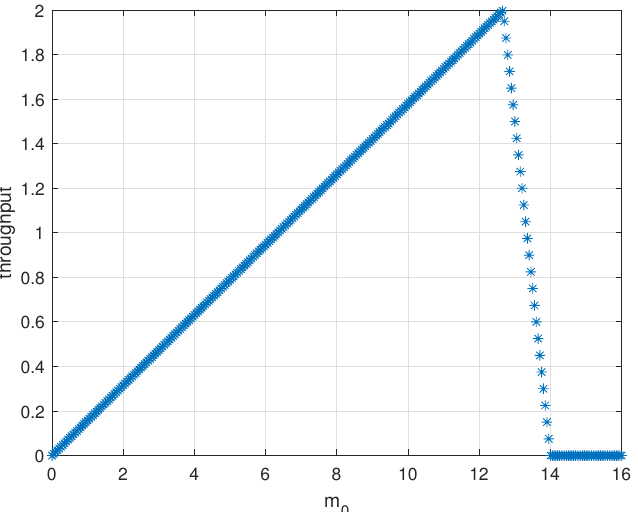
Figure 12. Non-monotonicity of the system in Figure 1b with the deadlock of the equilibrium throughput for parameter m 0 ( p 1 ) = k 1 .